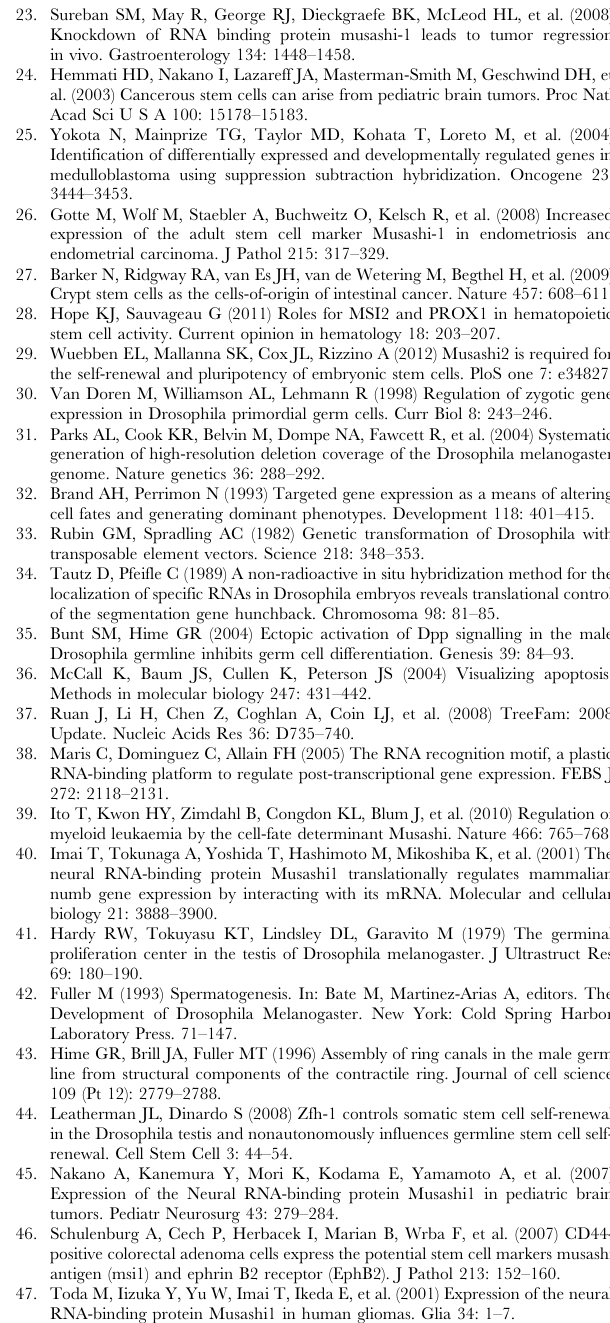
be delayed by 24 hours. (TIF) Figure S2 Numb expression is not altered in Rbp6 mutant tissue. (A–D). Numb expression remains unchanged in Rbp6 1 /Rbp6 3 mutant 3 rd instar brain lobes (B) compared to wild- type brain lobes (A), and in Rbp6 1 /Rbp6 3 mutant adult testes (D) compared to wild-type testes (C). Scale bars: 20 m m.